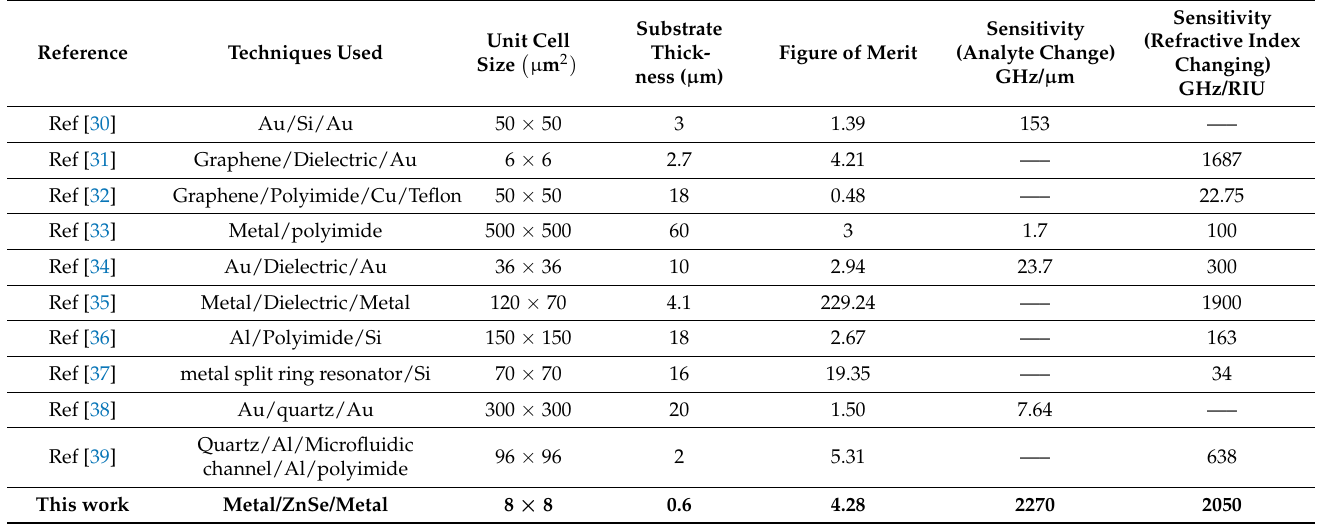
Table 2. Comparison of the sensing performance between the proposed works with similar THz absorber-based sensor studies.